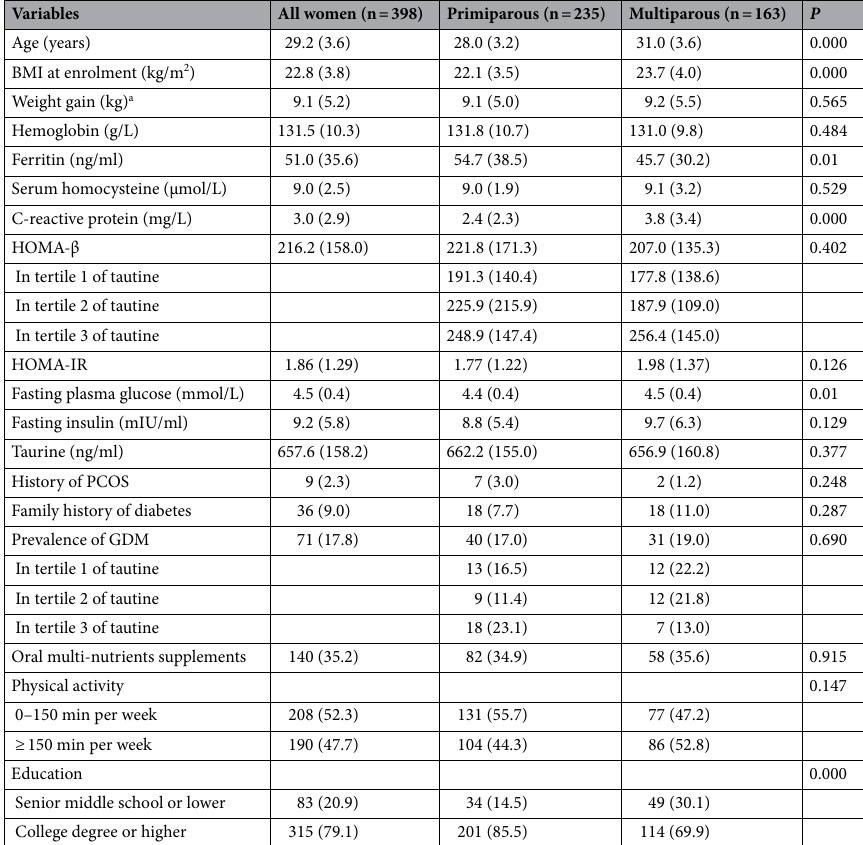
Table 1. Baseline characteristics of study population. BMI body mass index, HOMA-IR homeostasis model assessment—insulin resistance, HOMA-β homeostasis model assessment-β, PCOS polycystic ovary syndrome, GDM gestational diabetes mellitus. a Represents weight gain from enrolment to the 75-g oral glucose tolerance test.